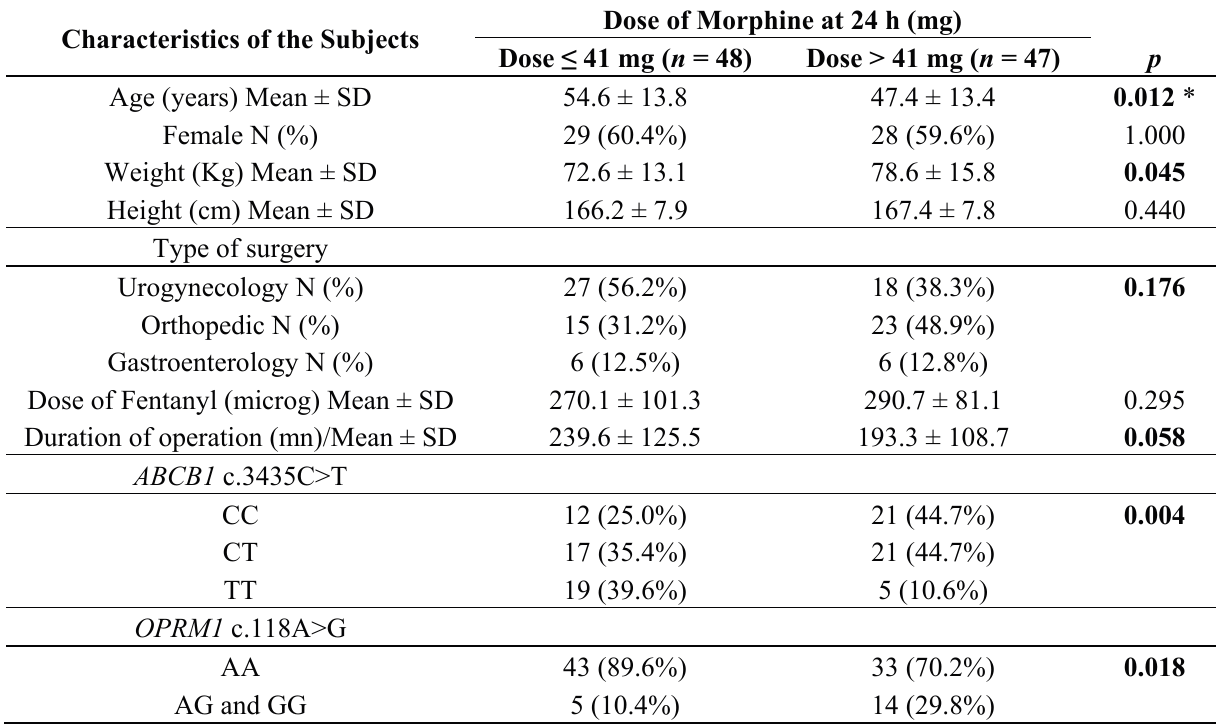
Table 3. Comparisons of patients’ distribution and mean values of characteristics between groups of subjects differing in morphine dose at 24